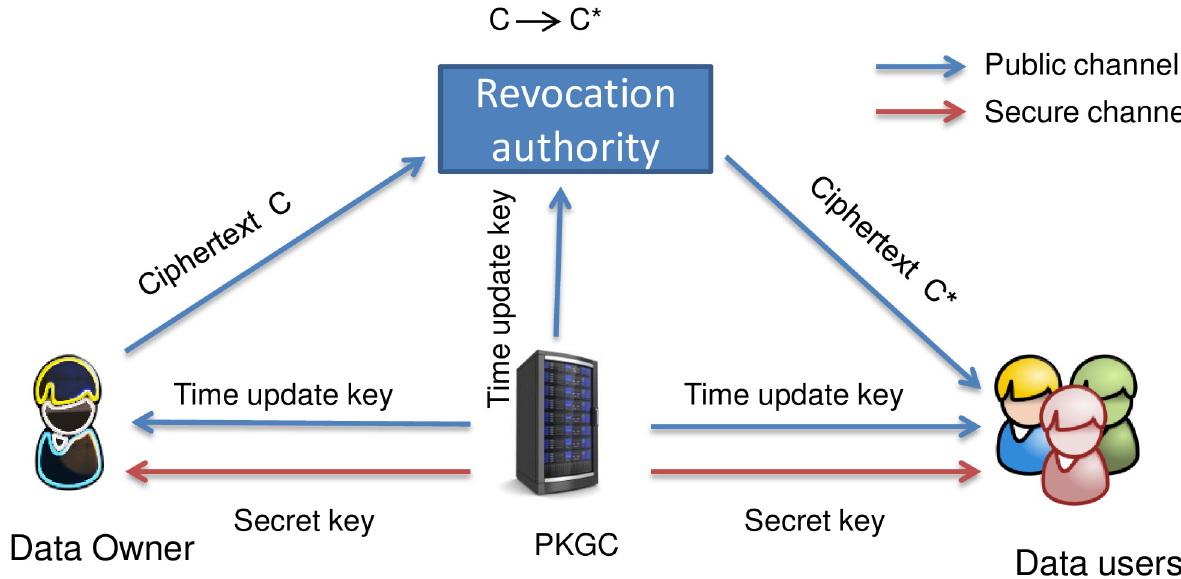
Fig 2. A system model for online data